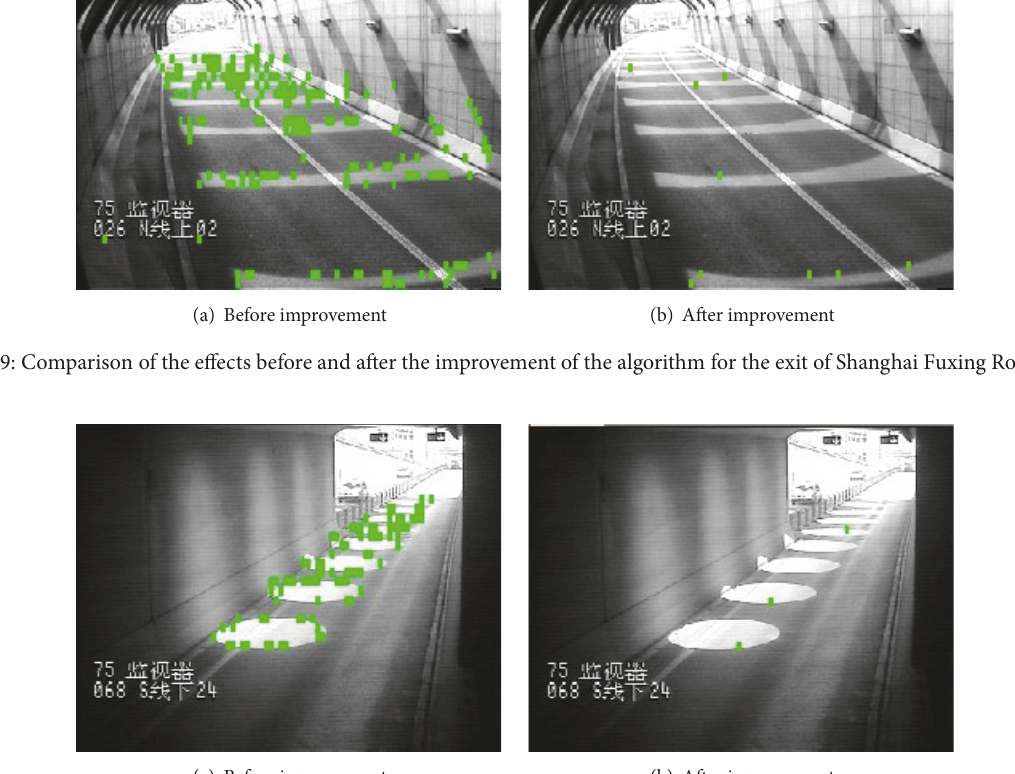
is simple, convenient, and widely used. Therefore, this paper uses SAD as the selection criterion for the optimal matching